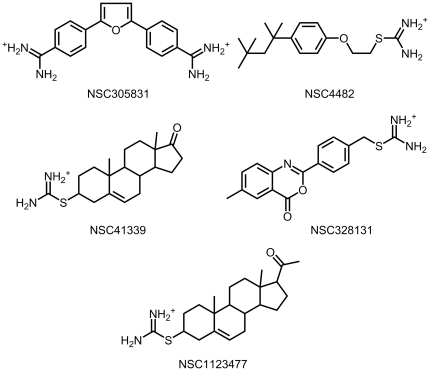
Structures of the five best compounds received from NCI.NCI ID numbers are indicated.